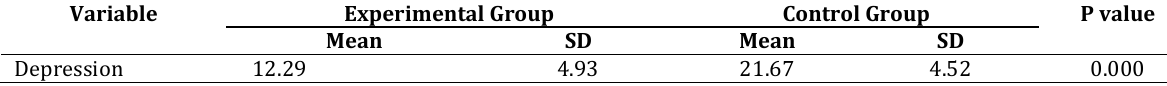
Table 3. Distribution of Experimental and Control Group Regarding Indicator of BDI in